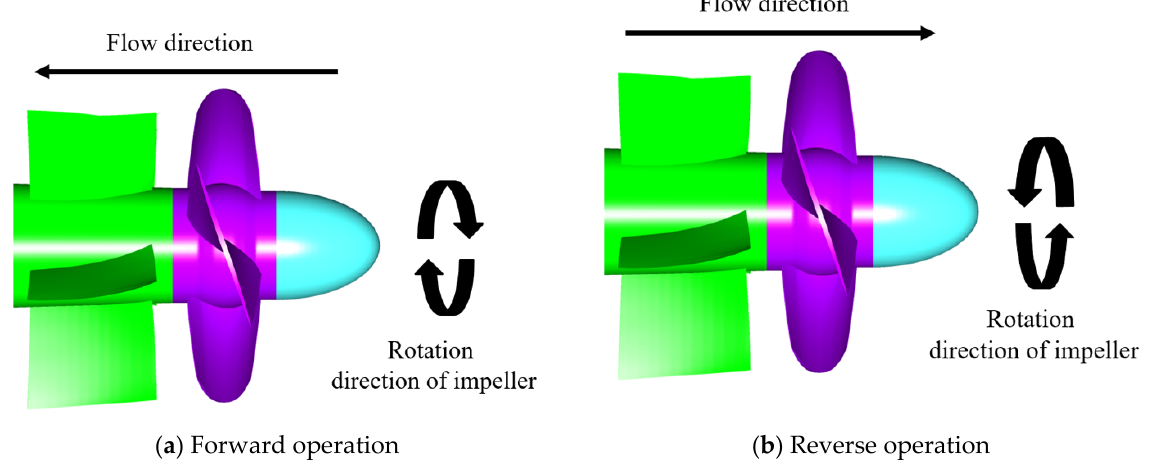
Figure 2. Rotation direction of impeller of bidirectional axial flow pump.